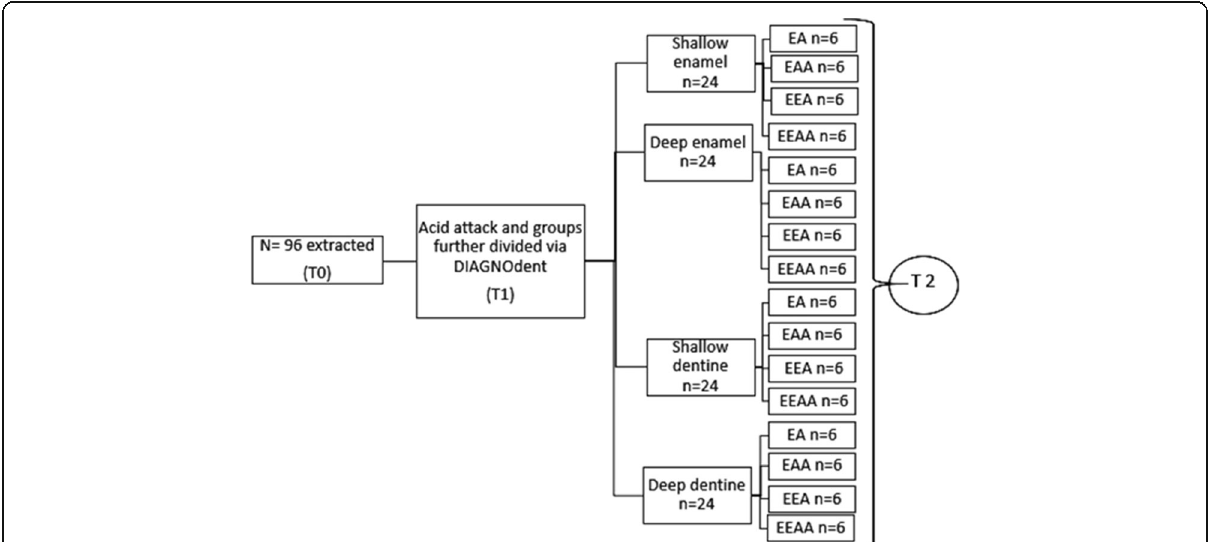
Fig. 4 Flowchart of the study. T0, color of the teeth spectrophotometry measured at baseline. T1, color of the teeth spectrophotometry measured after the WSL formation. T2, color of the teeth spectrophotometry measured after different protocols of resin